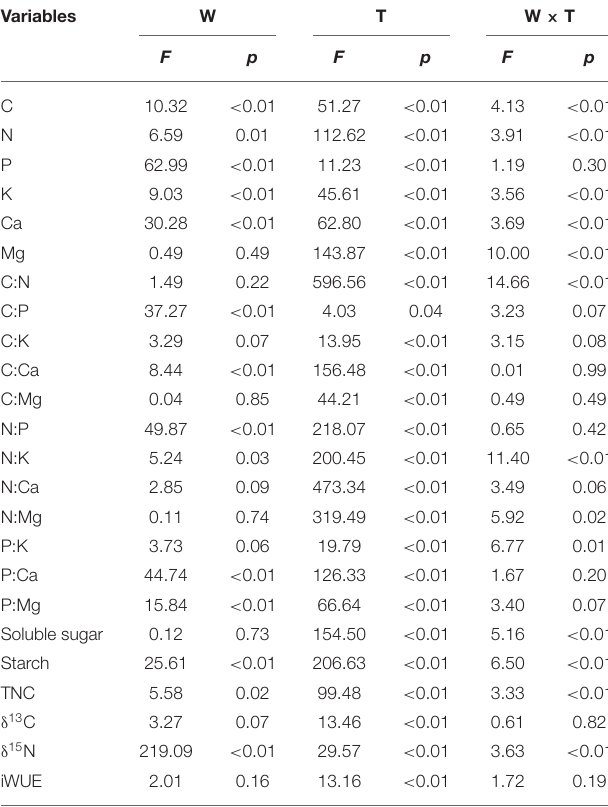
TABLE 2 | Main effects of warming, time, and their interactions on foliar chemical properties using an ANCOVA with soil moisture as the covariate.